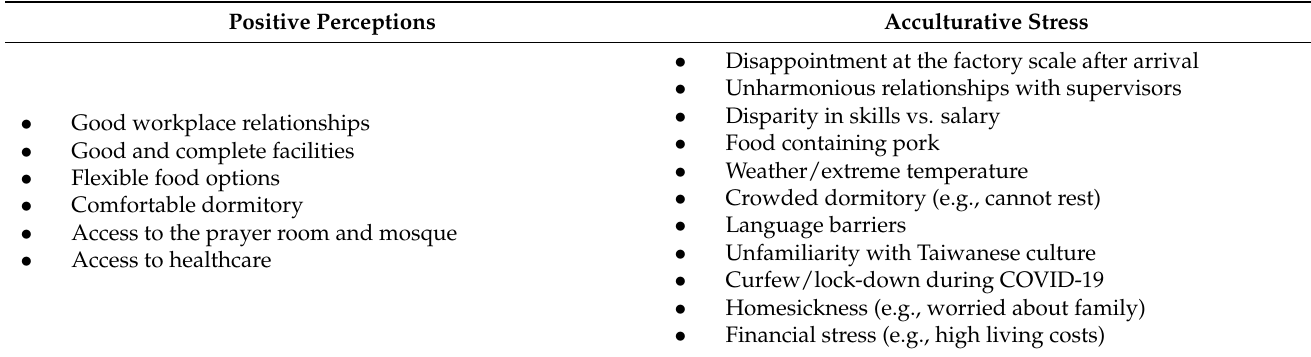
Table 1. Perceived acculturation